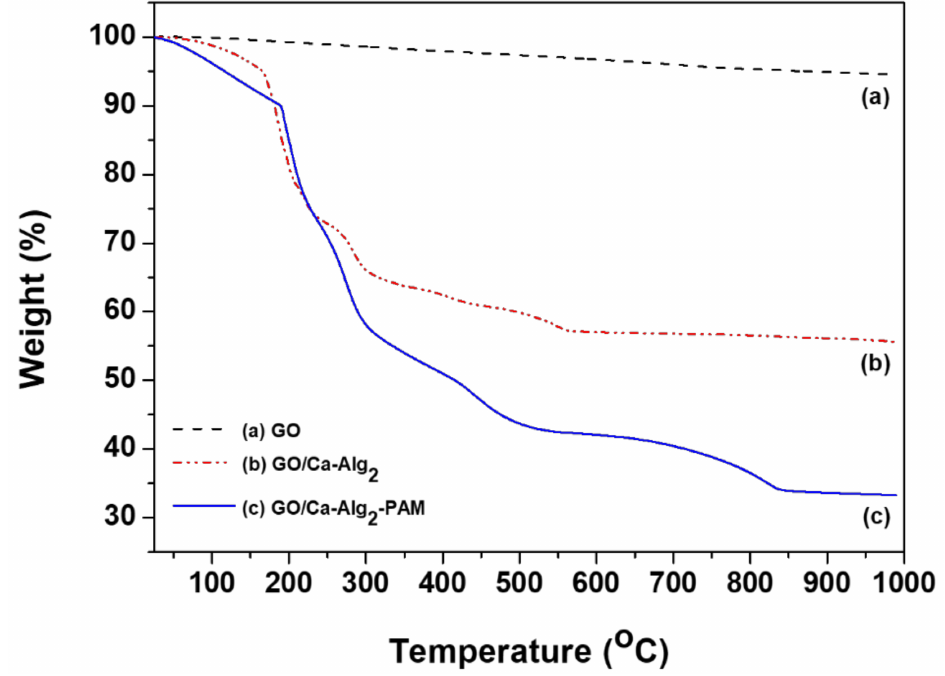
Figure 3. Thermogravimetric analysis curves of ( a ) graphene oxide, ( b ) GO/Ca-Alg 2 , and ( c ) GO/Ca- Alg 2 –PAM.